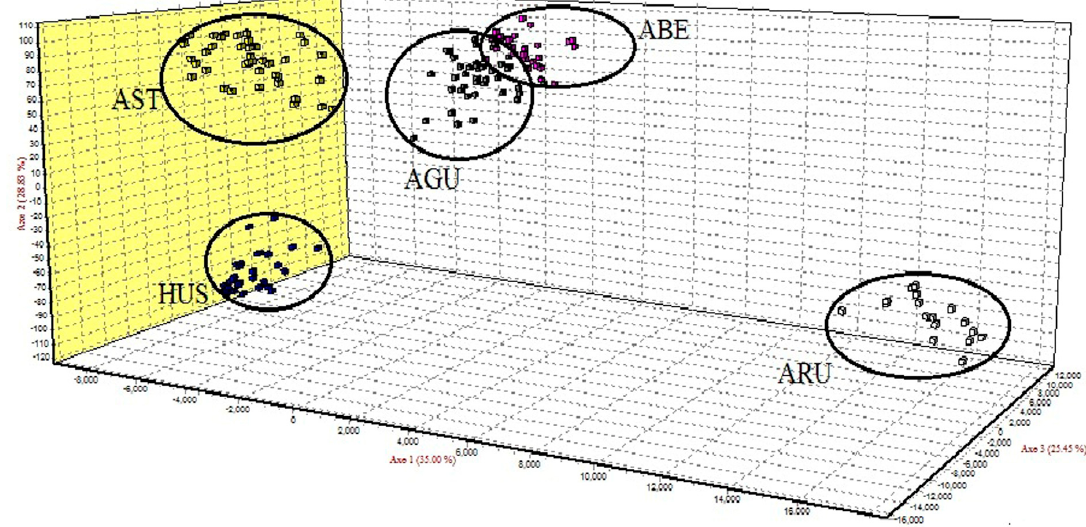
Figure 2. Factorial correspondence analysis (FCA) based on microsatellite data in five sturgeon species. HUS— H. huso ; AST— A. stellatus ; ARU— A. ruthenus ; AGU— A. gueldenstaedtii ; ABE— A. baerii.